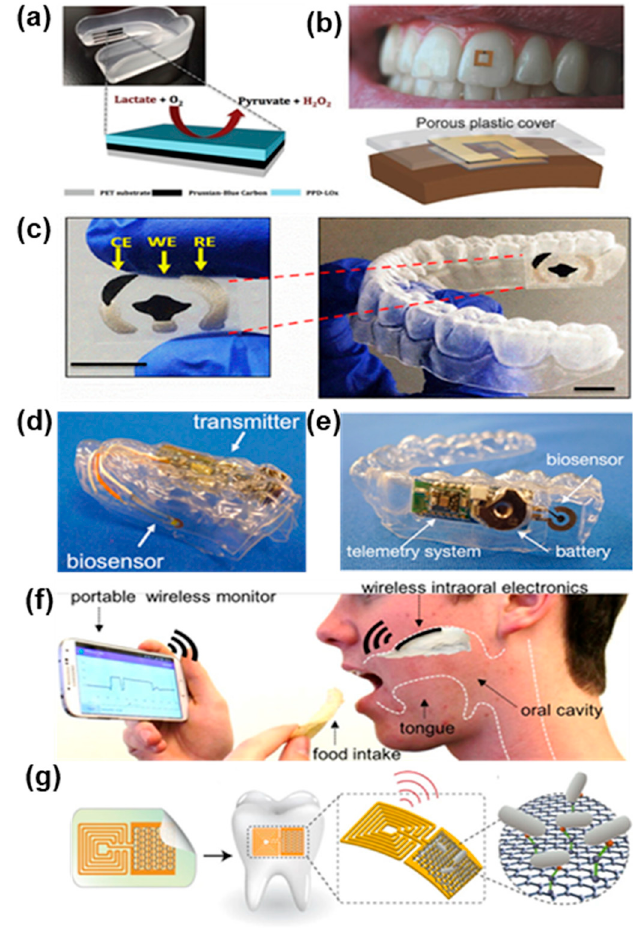
Figure 9. Wearable biosensing platforms for non-invasive salivary analysis ( a ) Lactate biosensor on